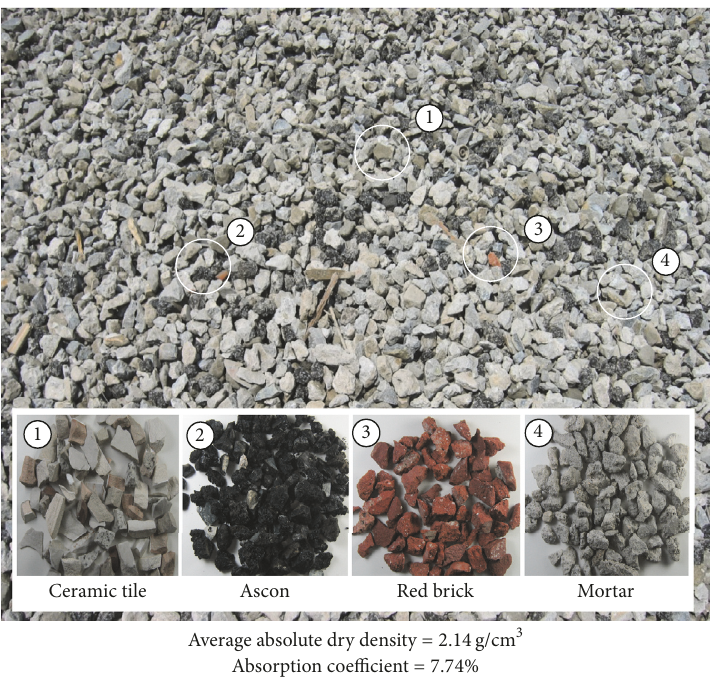
Figure 2: Recycled aggregates from construction demolition waste (CDW) produced by a conventional recycling plant in